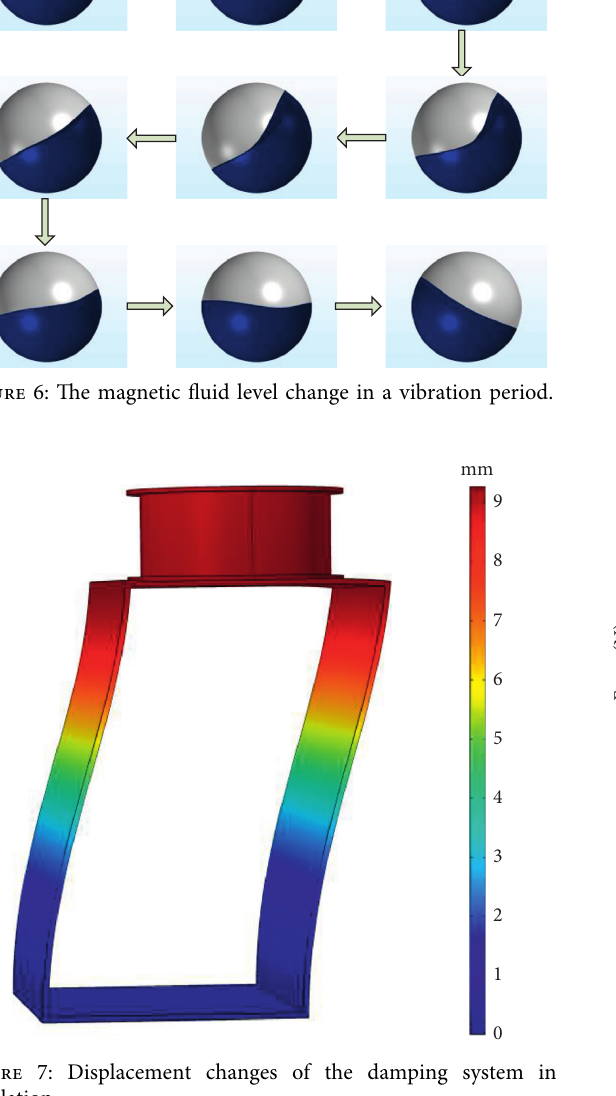
Figure 7: Displacement changes of the damping system in simulation.